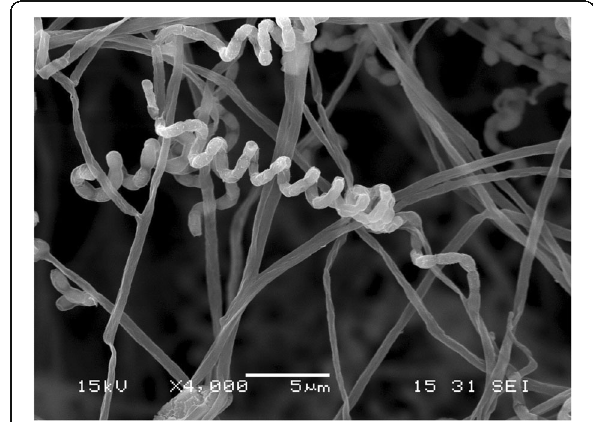
Fig. 1 Scanning electron micrograph of Streptomyces hyaluromycini MB-PO13 T grown on 1/10 ISP 2 agar for 14 days at 28 °C. Bar, 5 μ m